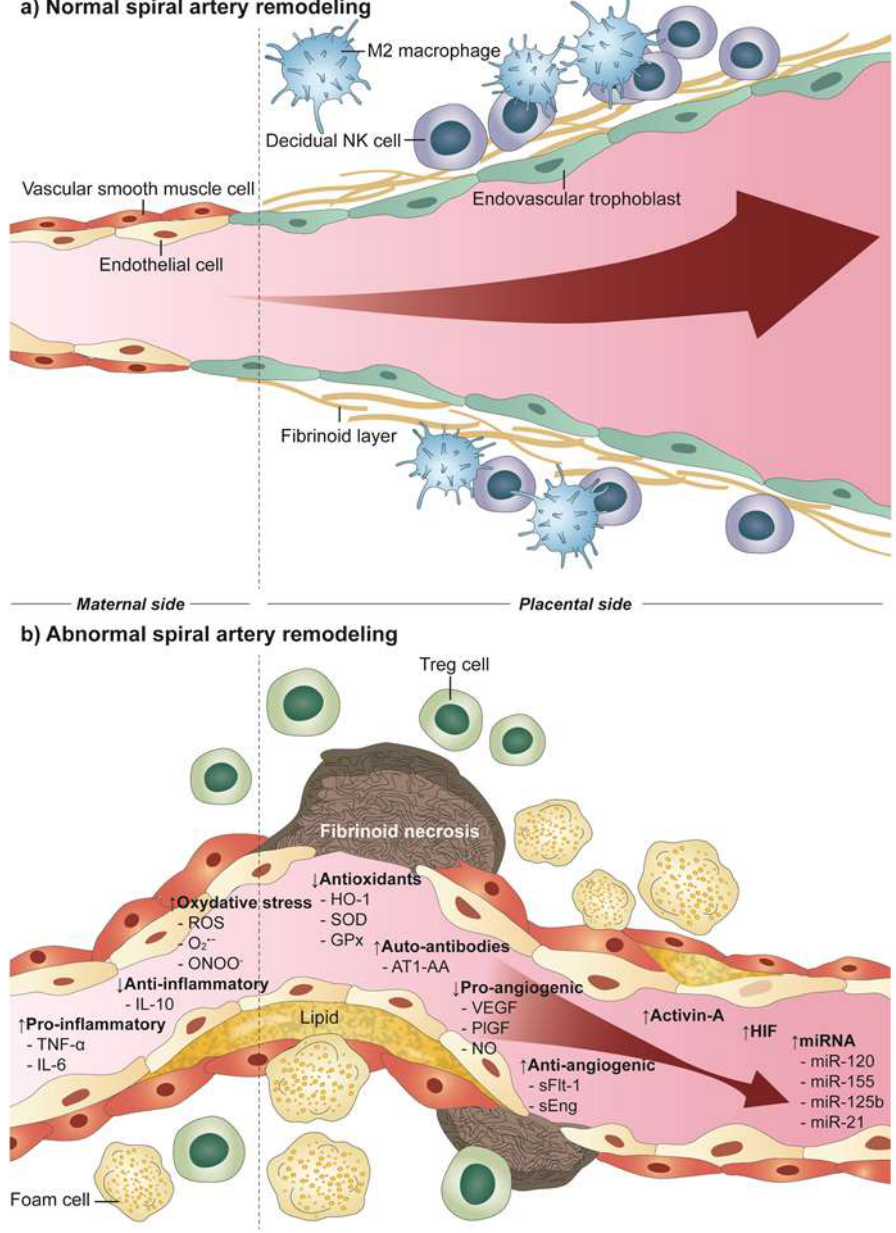
Figure 2. ( a ) Normal placentation with successful spiral artery remodeling. Endovascular trophoblasts become incorporated into the vessel wall and a fibrinoid layer substitutes the original smooth muscle cell layer, resulting in a low resistance vessel with a newly built thin, flexible wall which brings adequate uteroplacental perfusion. ( b ) Abnormal spiral artery remodeling in preeclampsia. Failure of endovascular trophoblast invasion results in a relatively narrow, thick-walled tortuous vessel with high resistance leading to reduced uteroplacental perfusion (RUPP). Atherosis is shown with lipid deposition in walls of spiral arteries with lipid-filled foam cells, perivascular lymphocytic infiltration and vascular fibrinoid necrosis. Various molecular factors resulting from RUPP are listed.